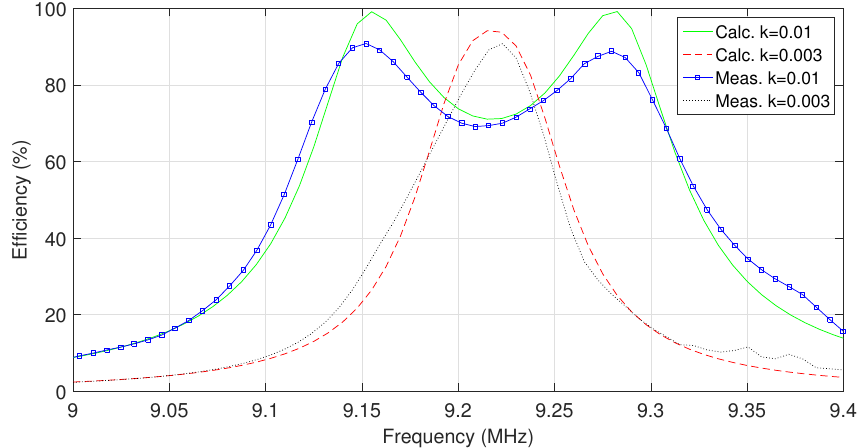
Figure 13. Comparison between the measured and calculated maximum efficiency and frequency pattern of the conventional system with a high Q of the coil. A designed system shows close similarities with the calculations.